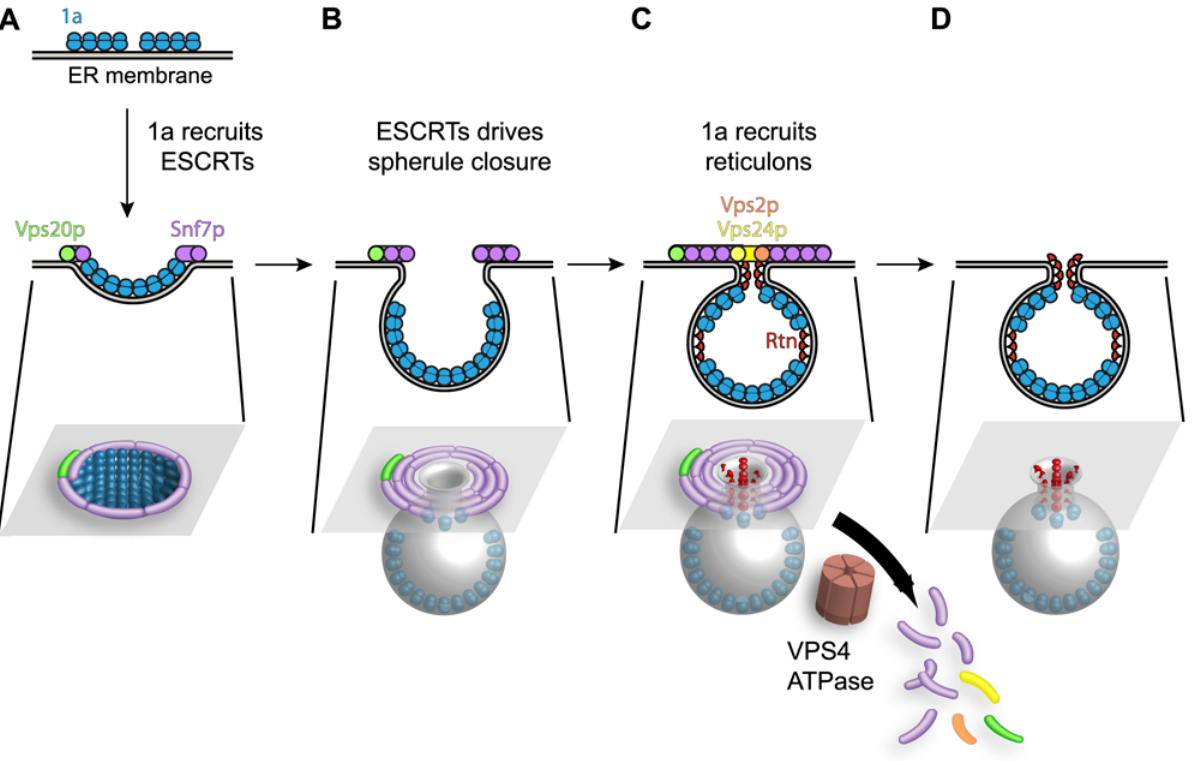
Fig 9. Model for the contribution of Snf7p and other ESCRT-III components to BMV spherule formation. (A) BMV 1a multimerization initiates perinuclear ER membrane invagination away from the cytoplasm, followed by recruitment of ESCRT proteins away from MVBs to the site of BMV RNA replication. (B) The concentric spirals formed by ESCRT-III components serve to constrict the wide membrane rim induced by 1a to bring the membrane lipids into close proximity to form the neck of the vesicle. (C) Unlike its natural role in MVBs where ESCRT-III continues to constrict the vesicle neck to efficiently cleave the bud to form intralumenal vesicles, either 1a, the reticulons (Rtn), which have been previously implicated in stabilizing spherule necks, or an unidentified protein prevent ESCRT-III from achieving membrane fusion, leaving an intact neck structure. (D) The ATPase Vps4p uses the energy of ATP hydrolysis to catalyze the disassembly of the ESCRT machinery and the recycling of its subunits from the membrane, leaving a spherule neck stably attached to the ER membrane.